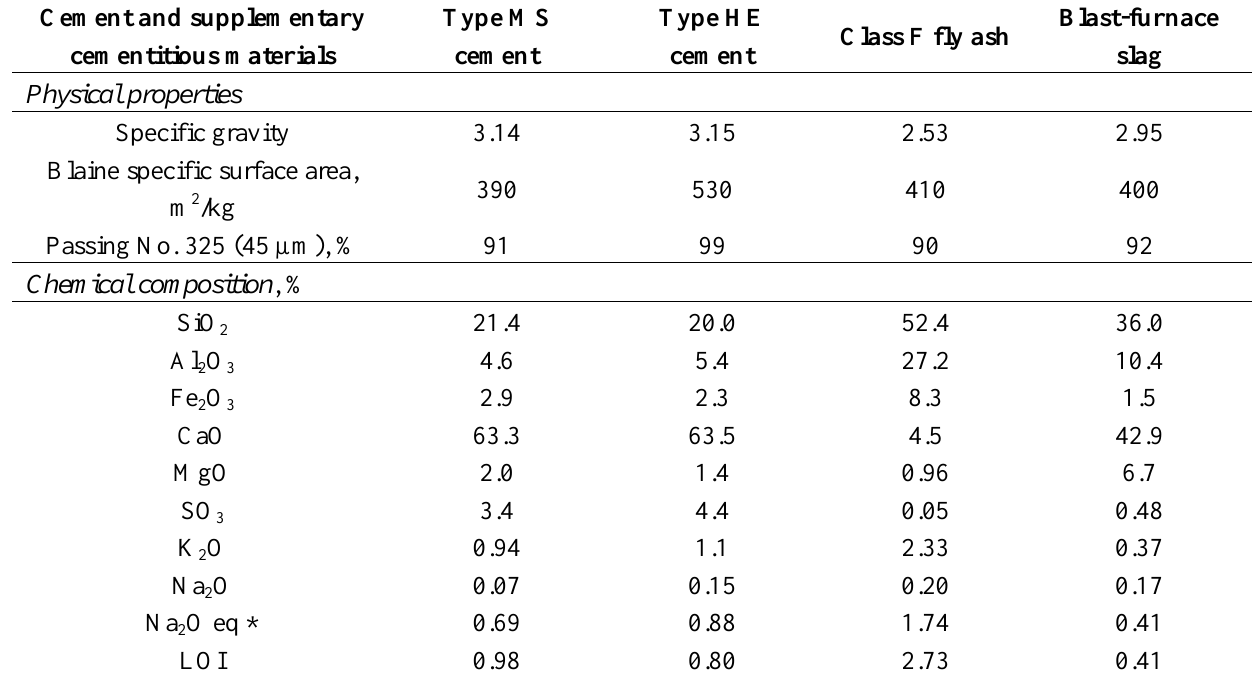
Table 2. Physical properties and chemical composition of cement and supplementary cementitious materials.